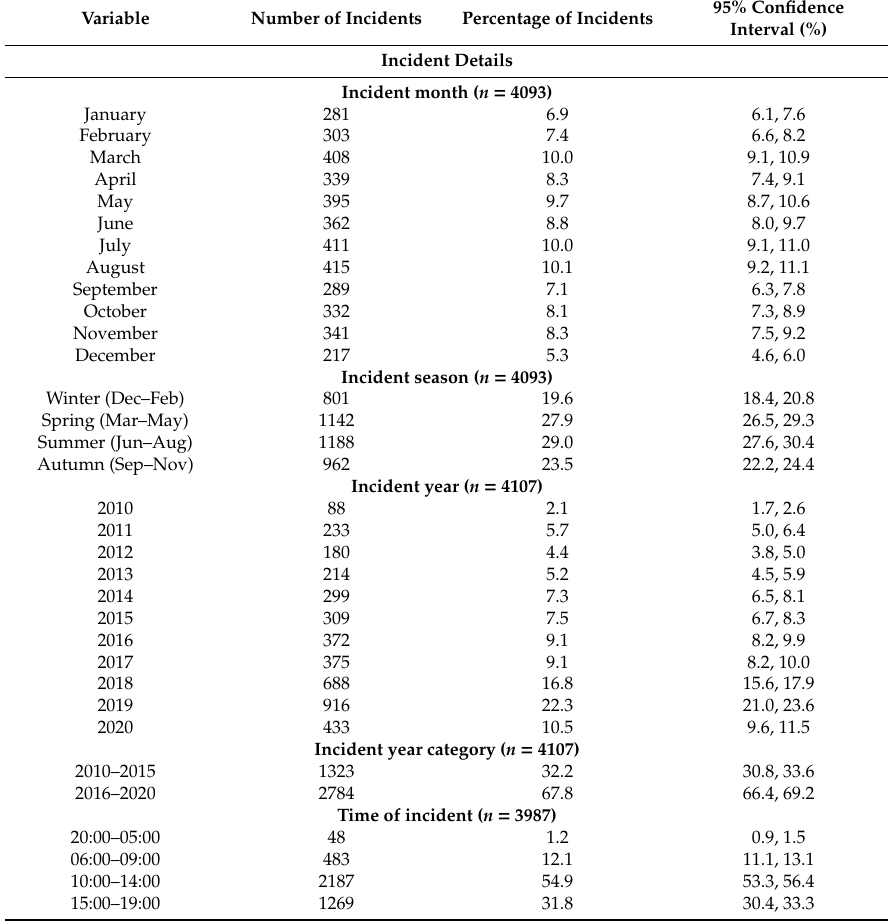
Table 1. A summary of equestrian-related road incident data reported to the British Horse Society between 2010 and